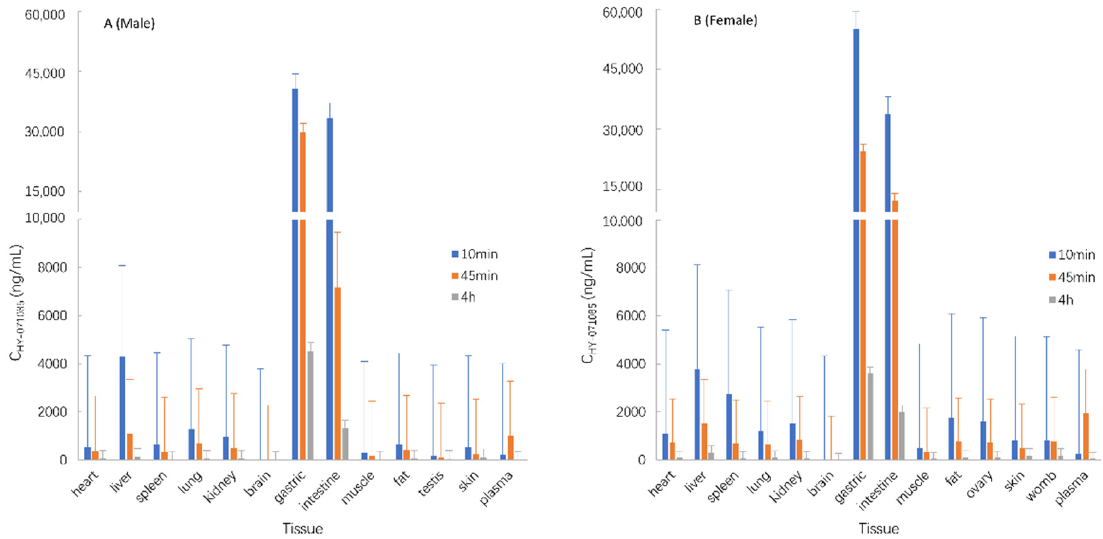
Figure 12. The drug concentration in tissues (ng/mL) after the intragastric administration of 13 mg/kg HY-071085 for 10 min, 45 min and 4 h (( A ) male; ( B ) female). Table 3. Material balance of the rats after the gavage of 6.5 mg/kg HY-071085 (mean ± SD). Tissue